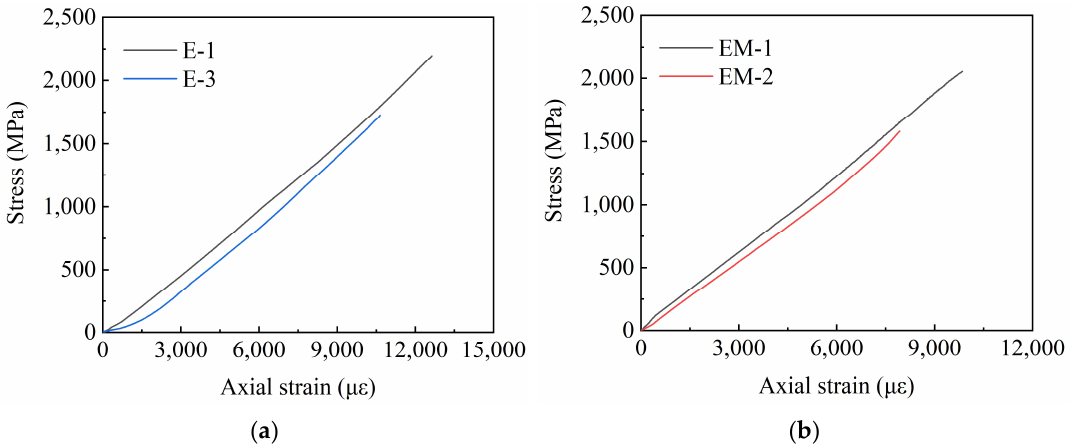
Figure 16. Average stress–strain curves of E-X and EM-X test groups. ( a ) E-X average stress–strain curve; ( b )EM-X average stress–strain curve.